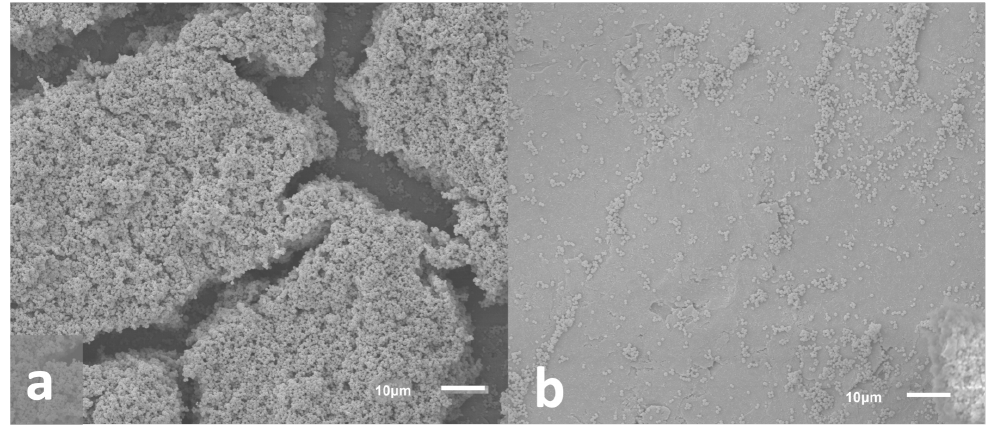
Figure 7. Representative SEM images of biofilms on the surface of Ti coupons. ( a ) Biofilm growth on Ti coupon prior to removal. Images indicated that biofilms grew to maturity with three-dimensional structures and likely water channels (caverns between structures). ( b ) Biofilm remaining on Ti coupon after removal with a cell lifter. Images indicated that cell lifters removed the majority of biofilm components including the basal layer.